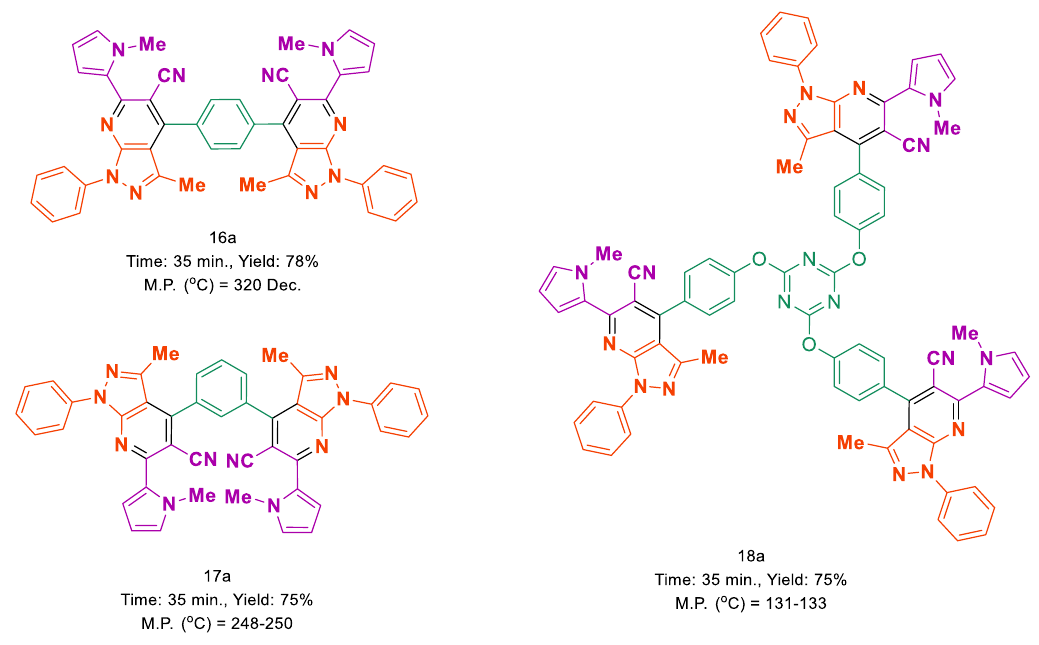
Table 3. Synthesis of ( N -methyl-pyrrol)-pyrazolo[3,4- b ]pyridines using MIL-53(Al)-N(CH 2 PO 3 H 2 ) 2 (10 mg) at 110 °C under solvent-free